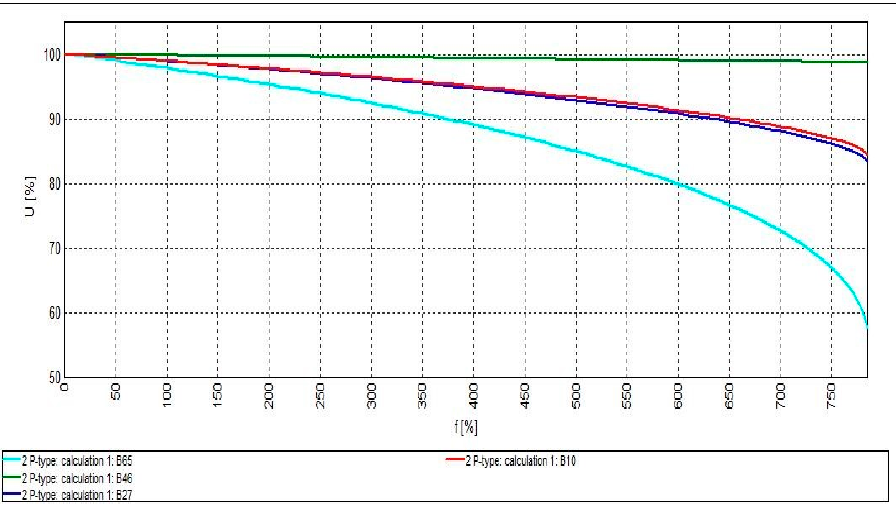
Figure 5. PV curves of the IEEE 69 ‐ node RDS system with 2 P ‐ type DG installations.